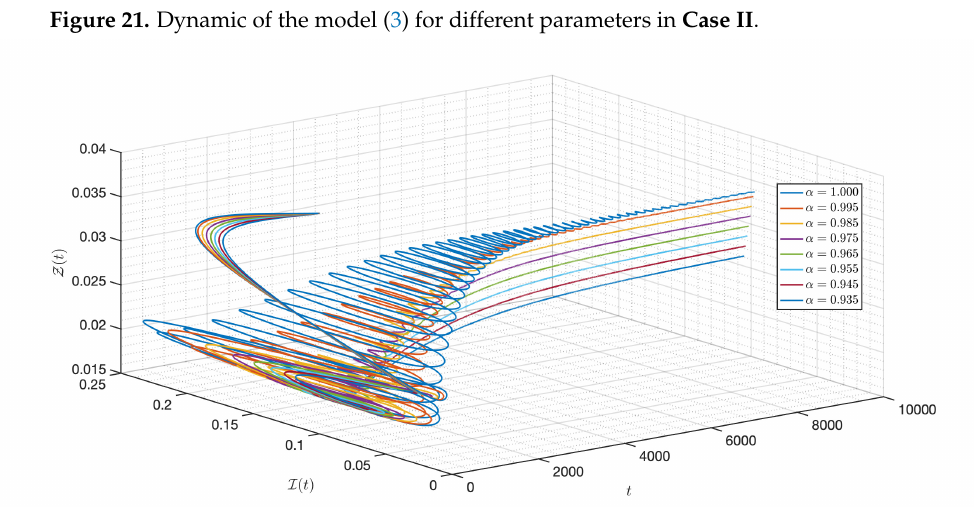
Figure 22. Dynamic of the model (3) for different parameters in Case II